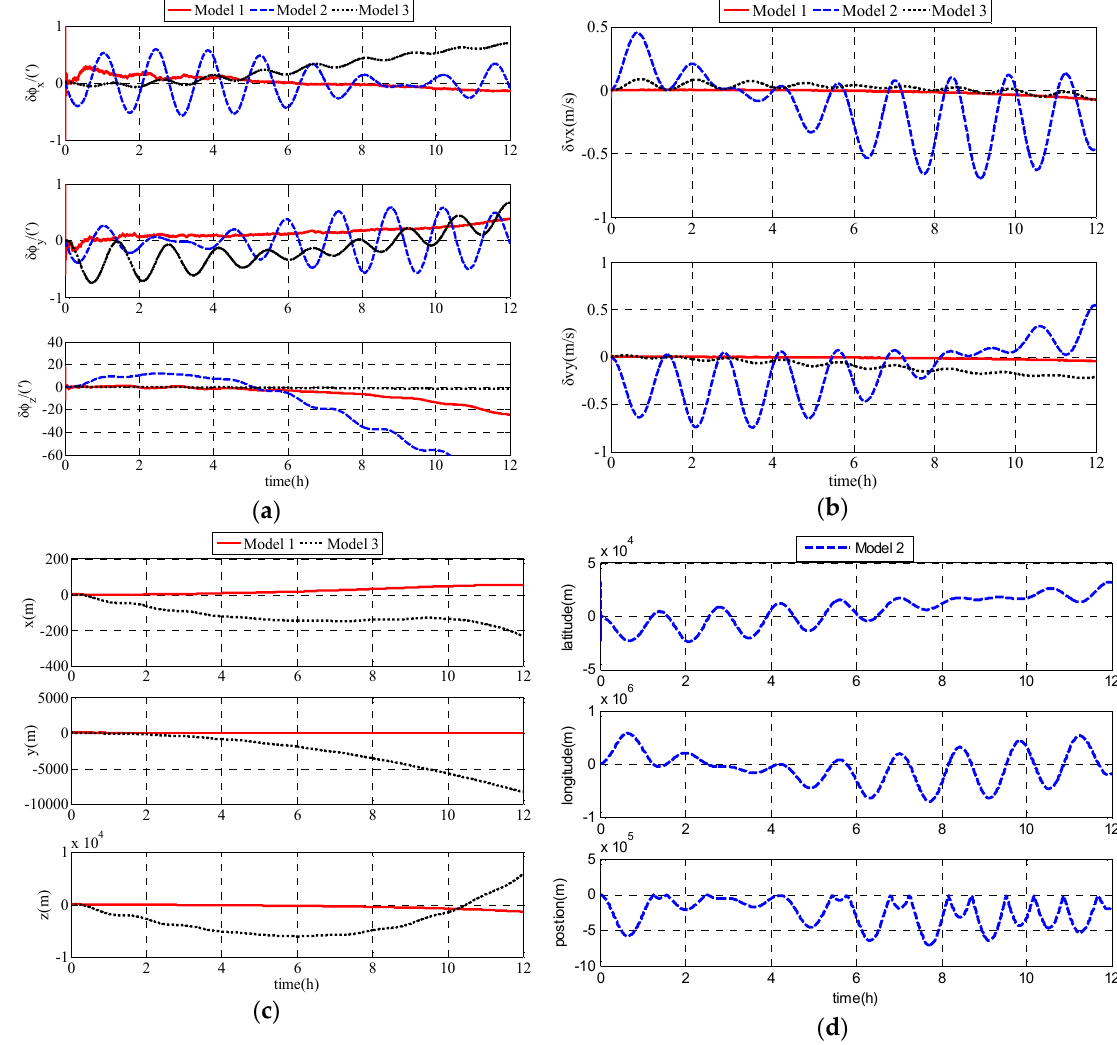
Figure 5. Simulation results: ( a ) attitude errors of the unmanned underwater vehicles (UUV); ( b ) velocity errors of the UUV; ( c ) position errors of Model 1; ( d ) position errors of Model 2.